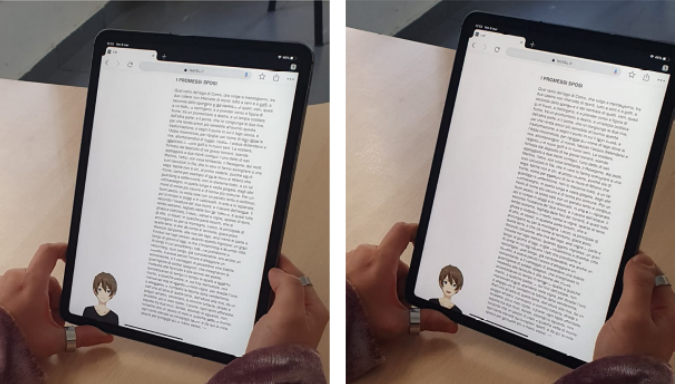
Figure 5. A simple reading application featuring MICA. ( Left ) The agent is observing the user. ( Right ) The agent is providing the user with a feedback about his or her level of attention while reading.